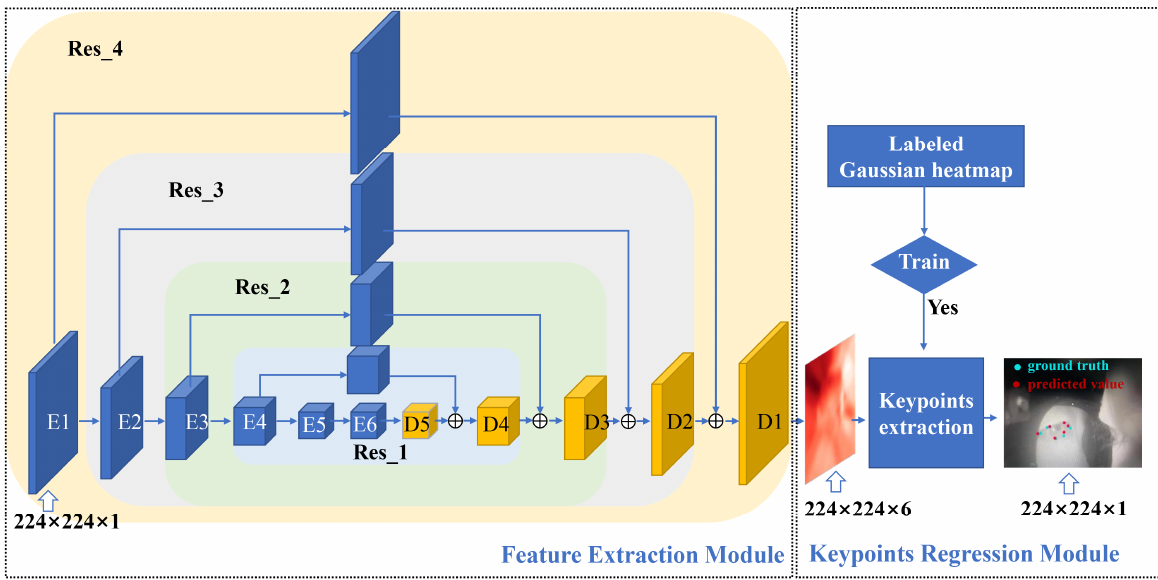
Figure 3. The architecture of the LGN network.